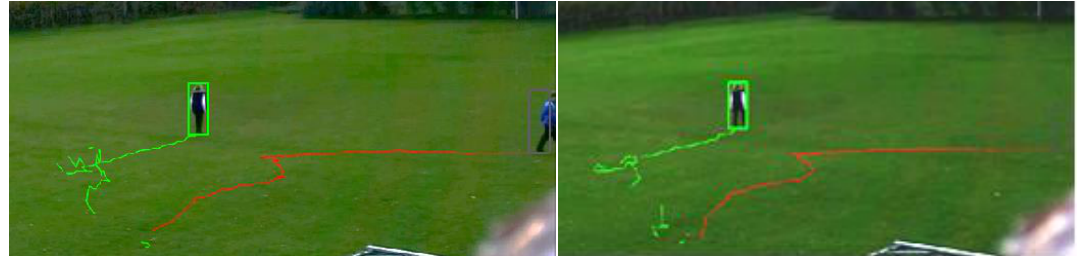
Figure 9. The results of the second experiment: ( a ) the scene containing both tracked objects and their trajectories; ( b ) top view of the complete dataset including the trajectories generated by GPS (both in black) and by our approach (red, green). Furthermore, three regions A, B and C (blue) are marked which contain situations being referred to in the text. ( c ) The result when GPS information is not